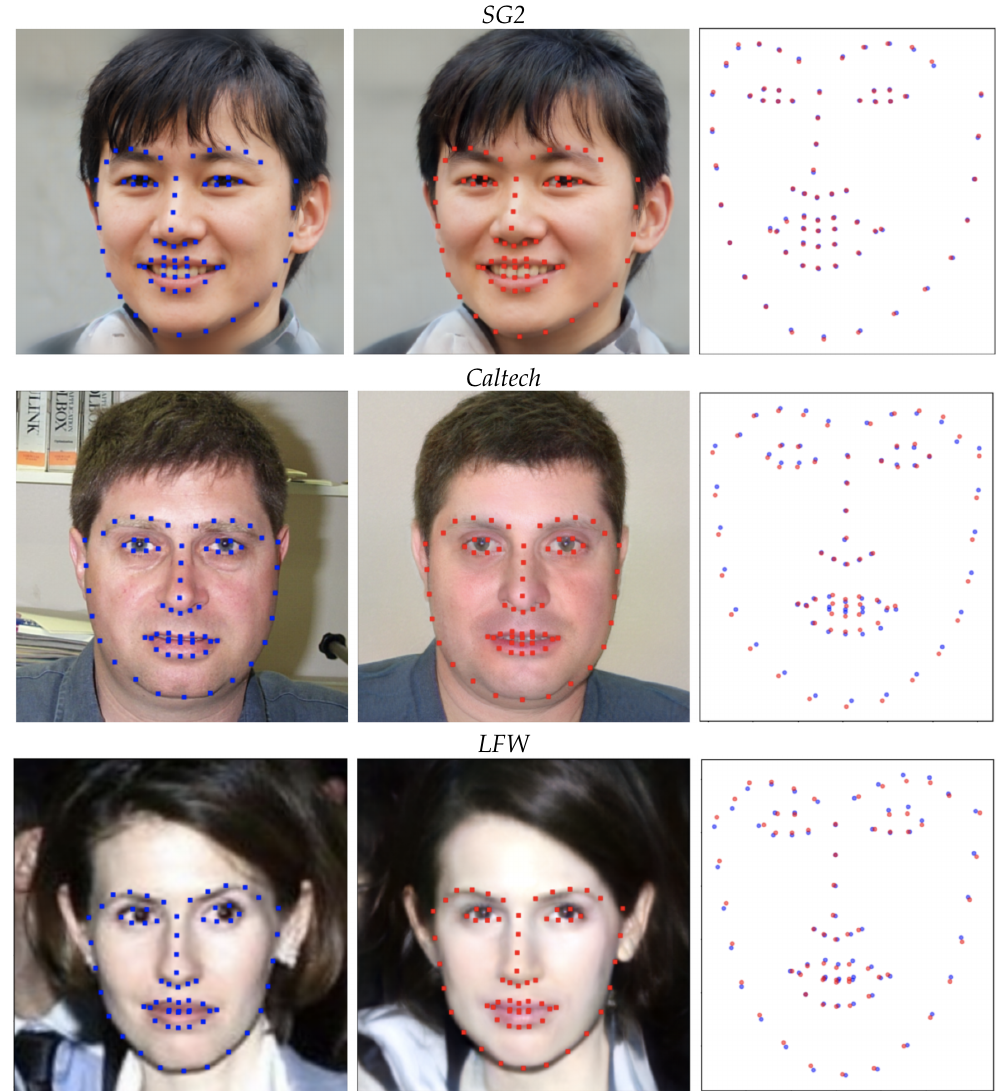
Figure 11. Visualization of the landmarks detected on the input and the reconstructed images from different datasets. In each case, the left image is the input one with the detected landmarks marked in blue, and the central one is the corresponding reconstruction with the detected landmarks marked in red. On the right, the two sets of landmarks are reported on the same spatial grid, so that their displacement can be